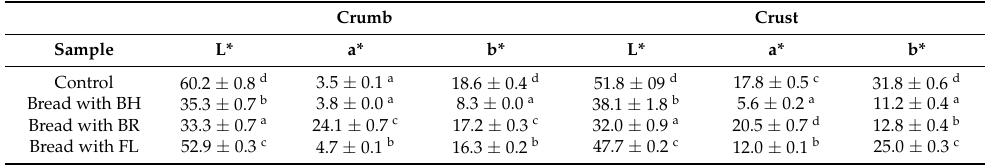
Table 7. Color parameters of bread crumb and crust.